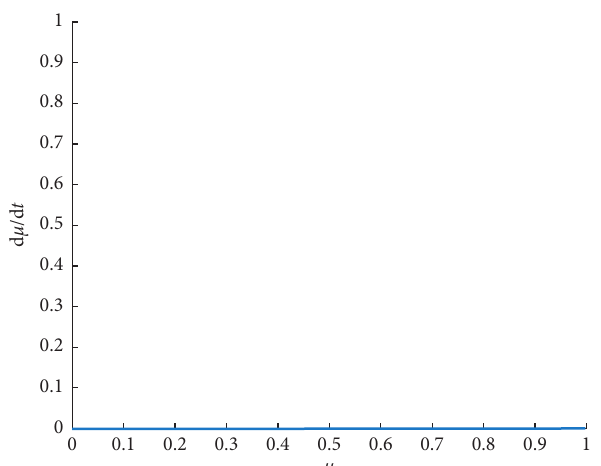
Figure 6: The evolution phase diagram when η � η ∗ .